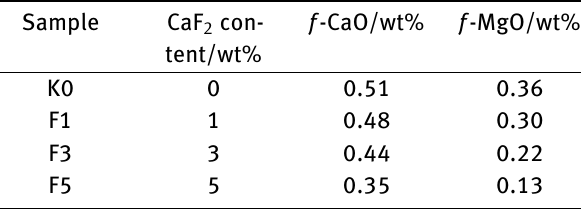
Table 4: Effect of CaF 2 on the f -CaO and f -MgO contents in the